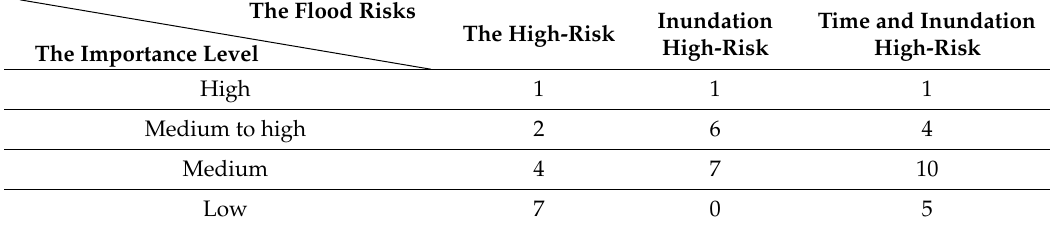
Table 4. Unit type